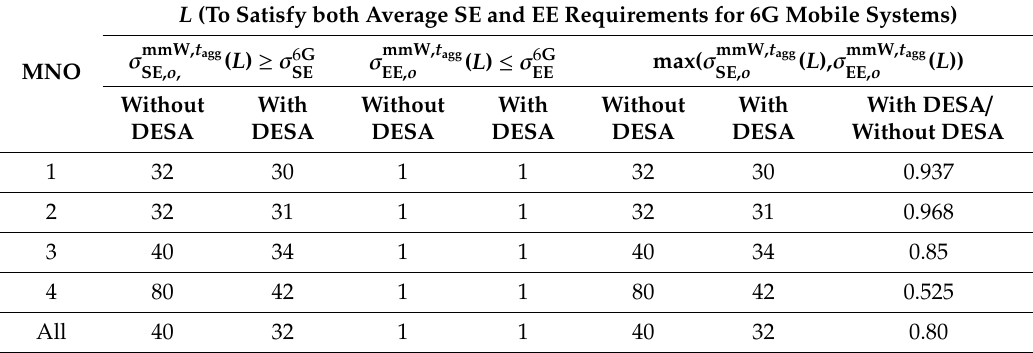
Table 2. Required values of L to satisfy both average SE and EE requirements for 6G mobile systems.